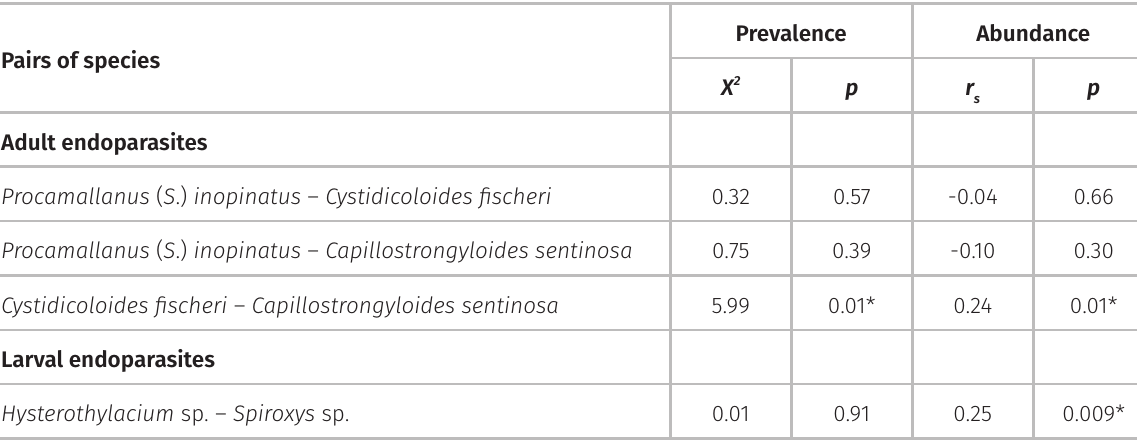
Pairs of species